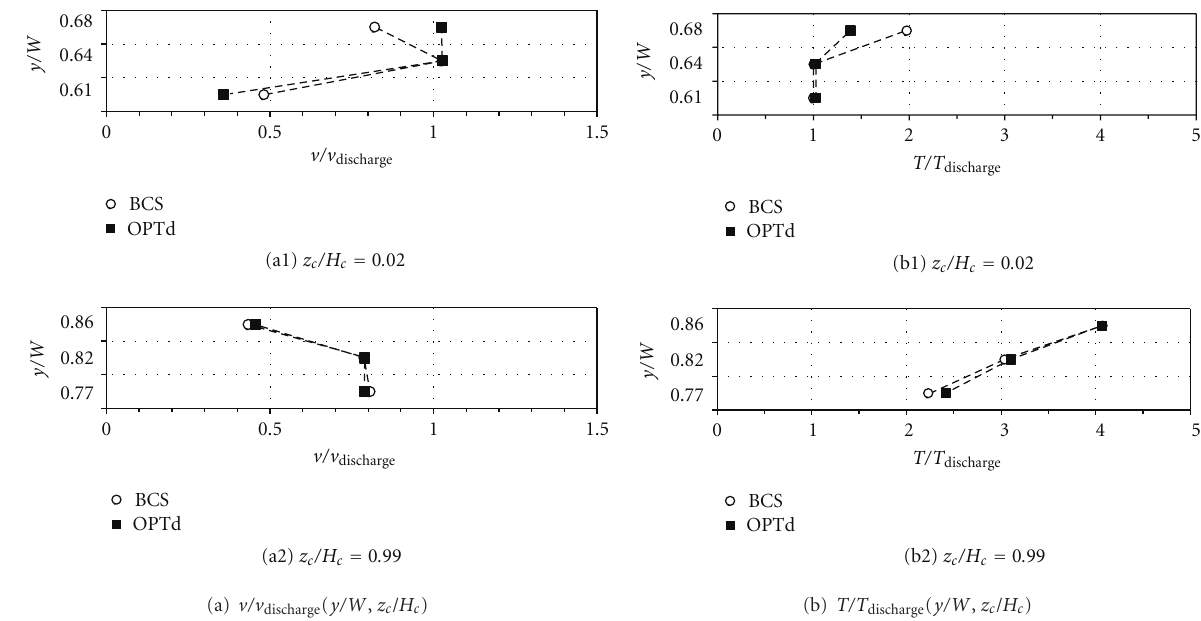
Figure 10: Comparative profiles of nondimensional air velocity, v/v discharge ( y/W , z c / H c ), and nondimensional air temperature, T/T discharge ( y/W , z c / H c ), in the air curtain—OPTd case study.